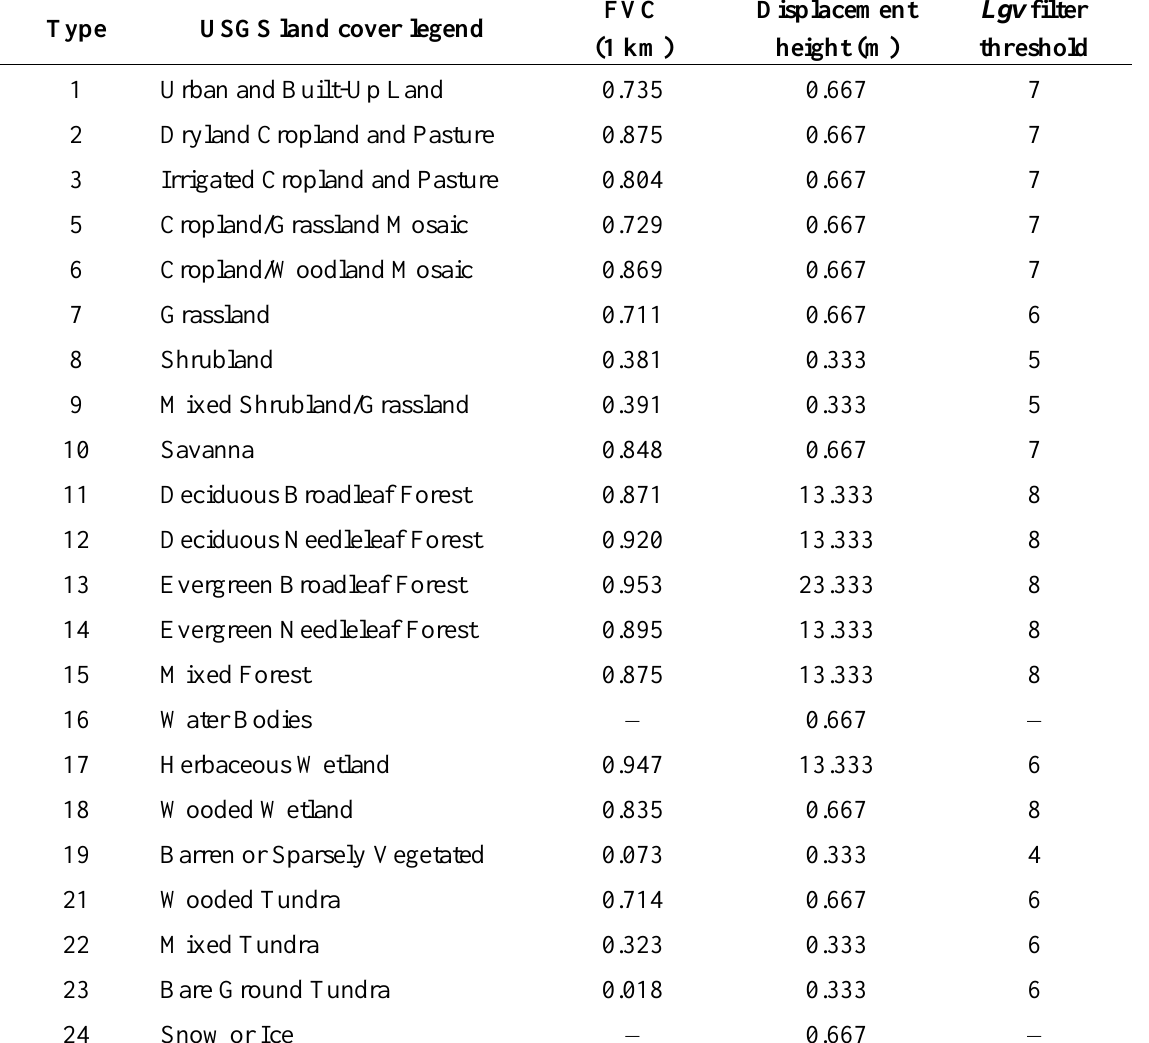
Table 2. Parameters in deriving LAI for each USGS Land